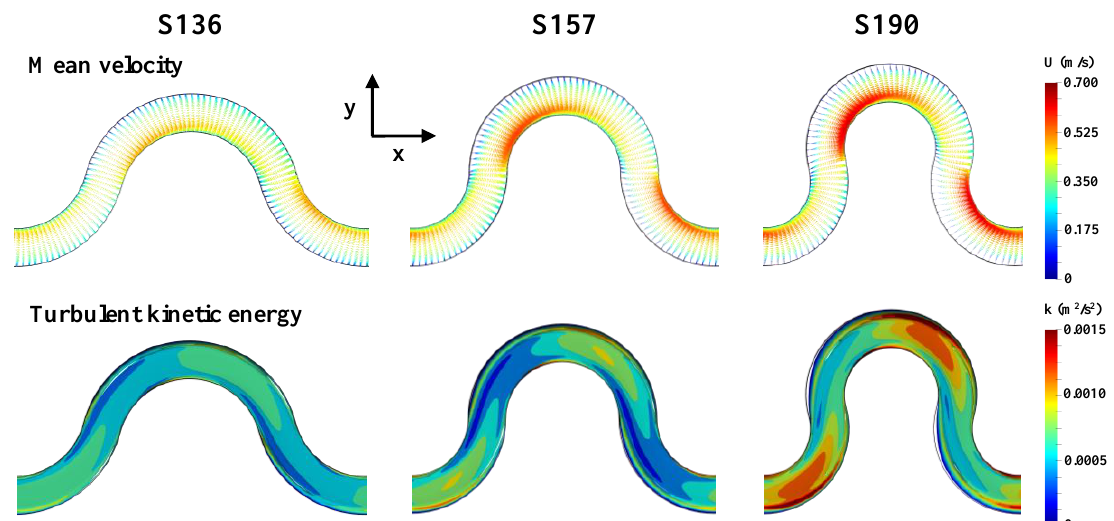
Figure 3. Mean velocity and turbulence fields at the free surface of a representative domain including the bend apex for simulation cases calculated with the SST k − ω model.